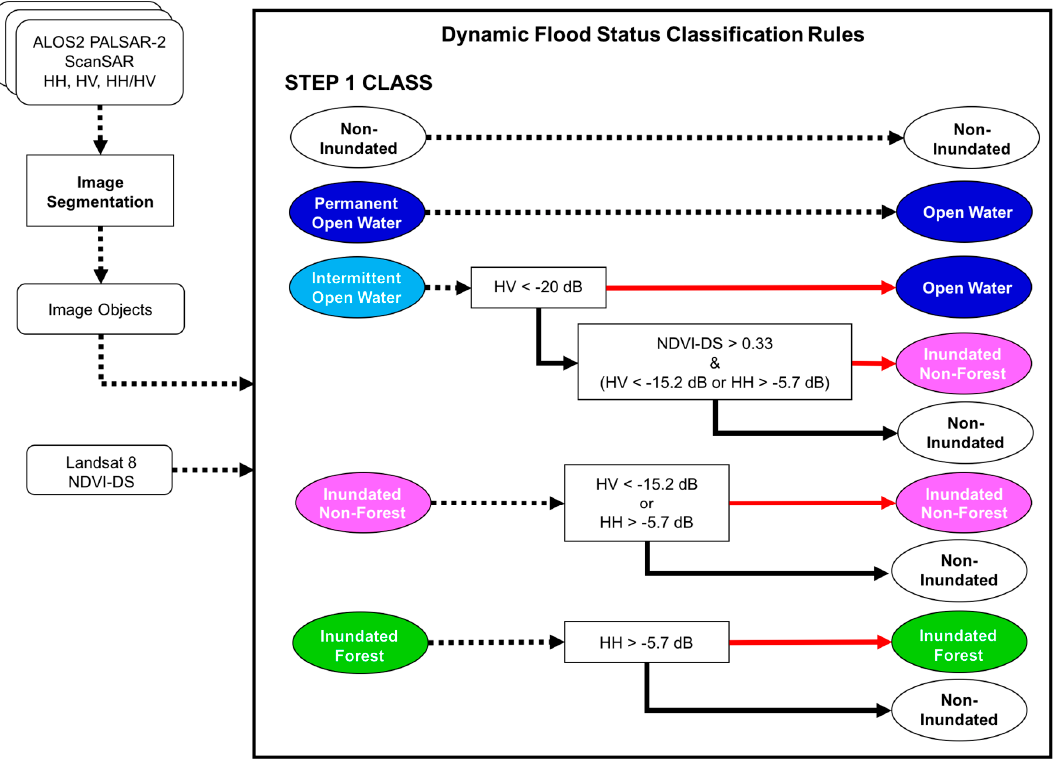
Figure 9. Step 2 object-based classification algorithm for delineating time series inundation state. Boxes with rounded edges indicate inputs; boxes with sharp corners indicate a process/decision; ovals indicate assigned classes. In the decision tree, bold red arrows correspond with “True” and bold black arrows with “False”.